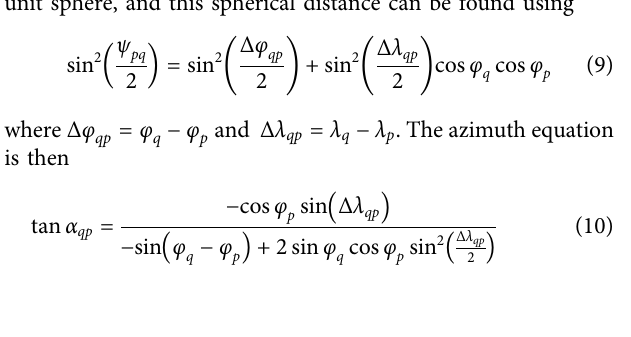
Frontiers in Earth Science |